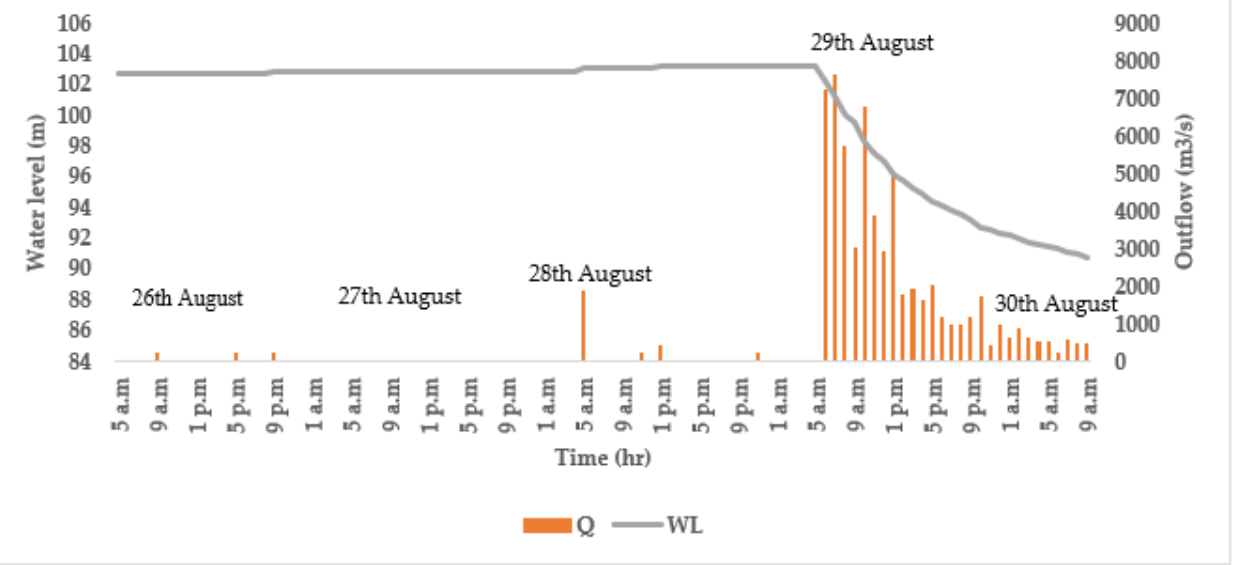
Table 3. Comparison of calculated results and observed data for Scenarios 1 and 2.